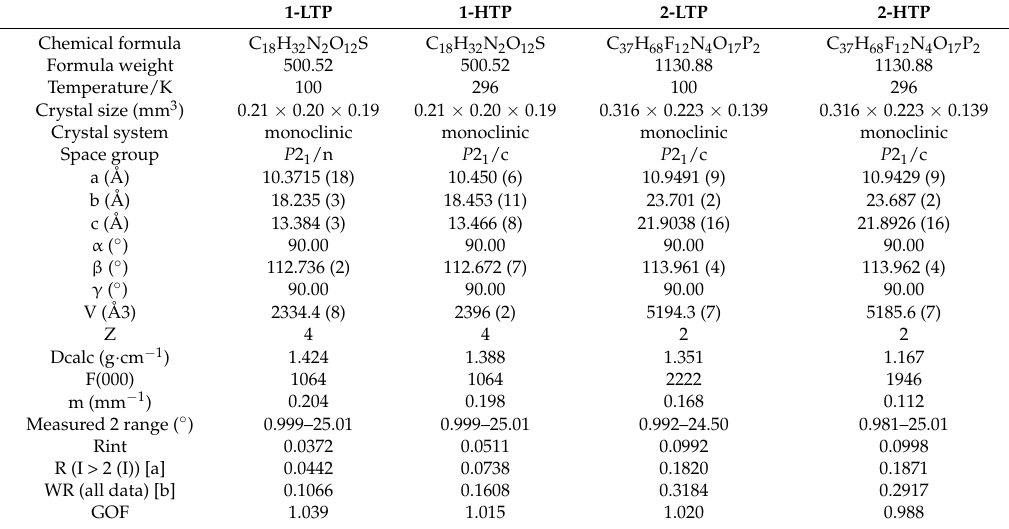
Table 1. Crystallographic data and structural refinement details for 1 and 2.